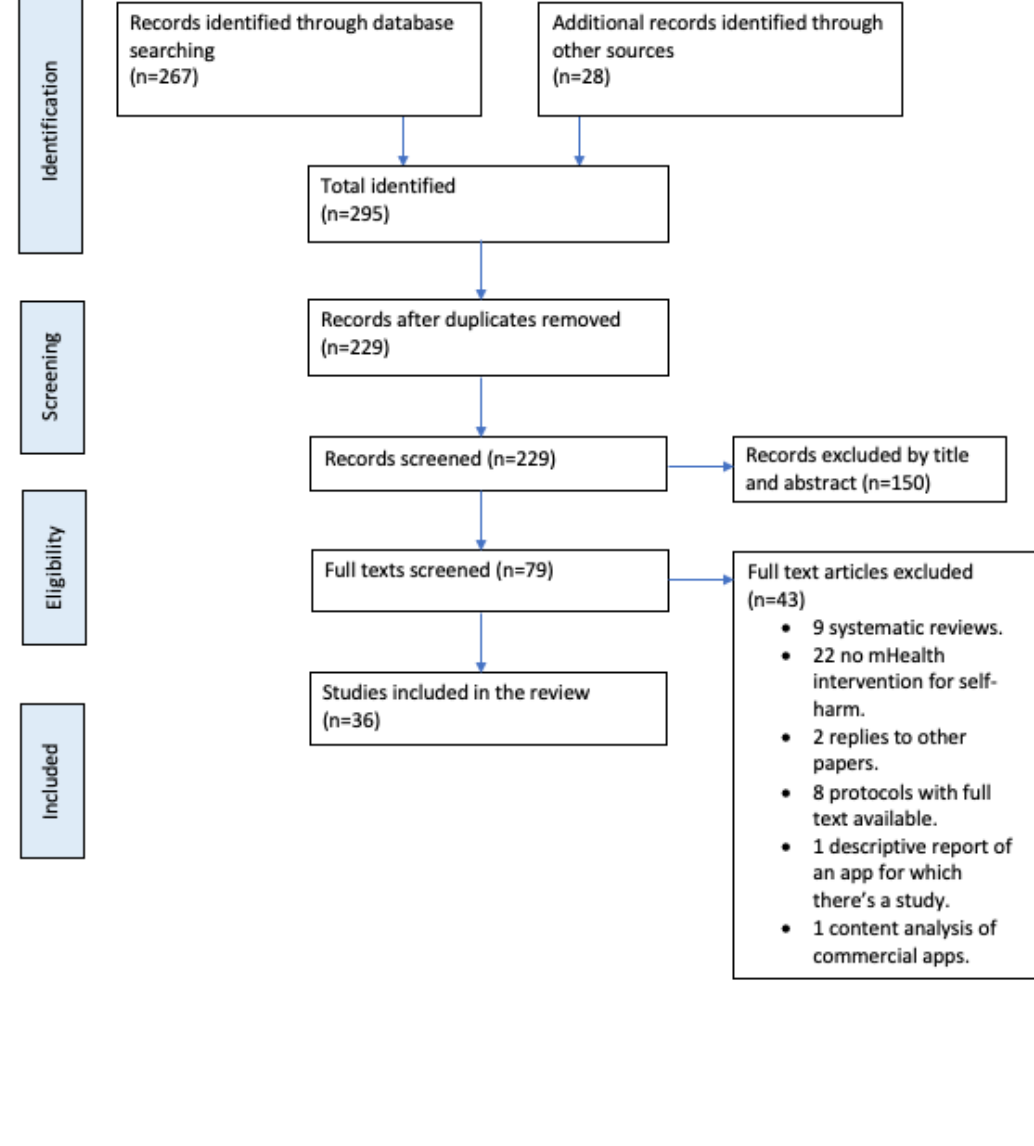
Figure 1. Flowchart of search results. mHealth: mobile